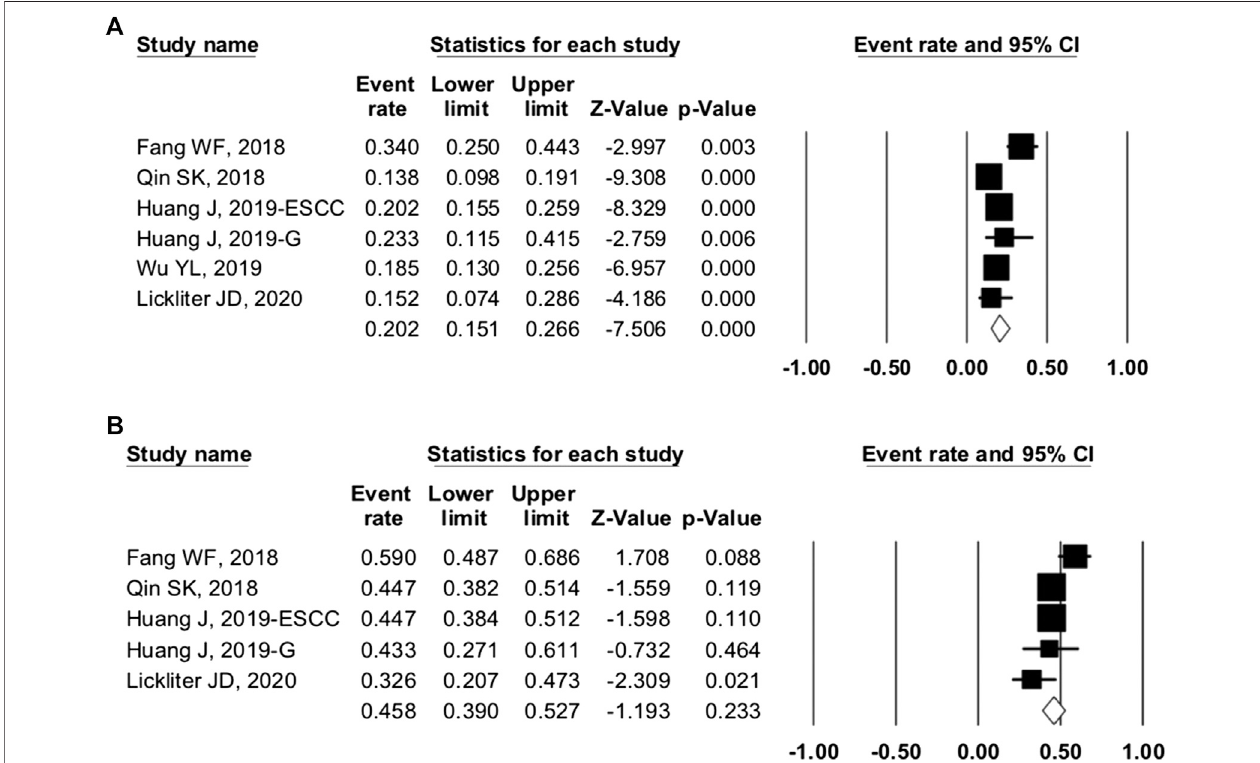
FIGURE 4 | Ef fi cacy of camrelizumab alone. (A) overall response rate and (B) disease control rate of included studies.